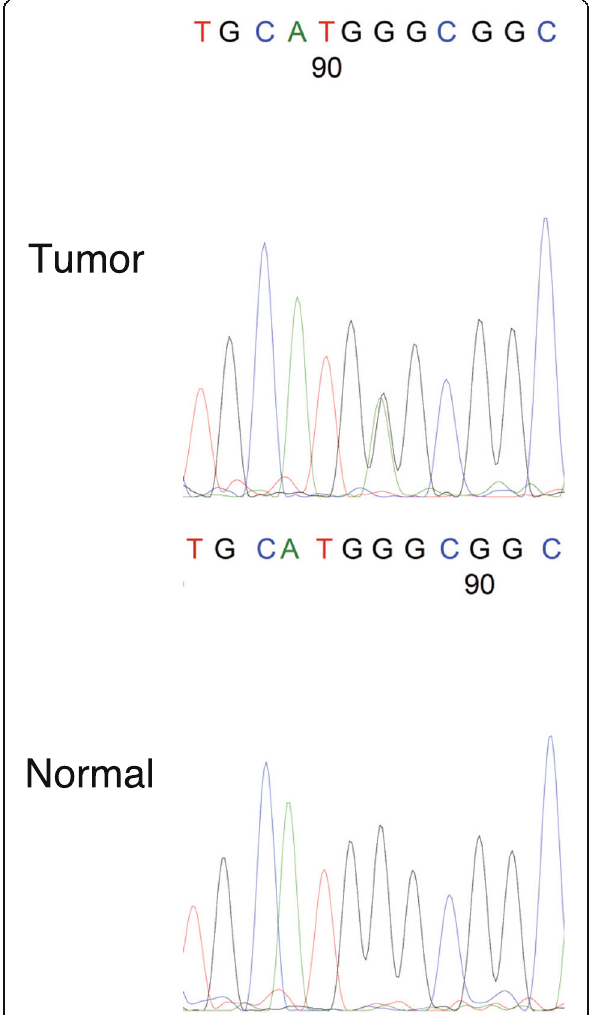
Fig. 3 TP53 mutation analysis of the ovarian tumor. A DNA sequence analysis of TP53 exon 7 from the ovarian tumor and normal tissue with the reverse-primer. The sequence of the ovarian tumor shows biallelic pattern at the coding DNA reference number 730, indicating that HGSC harbors a missense mutation (p.G244S) in the TP53